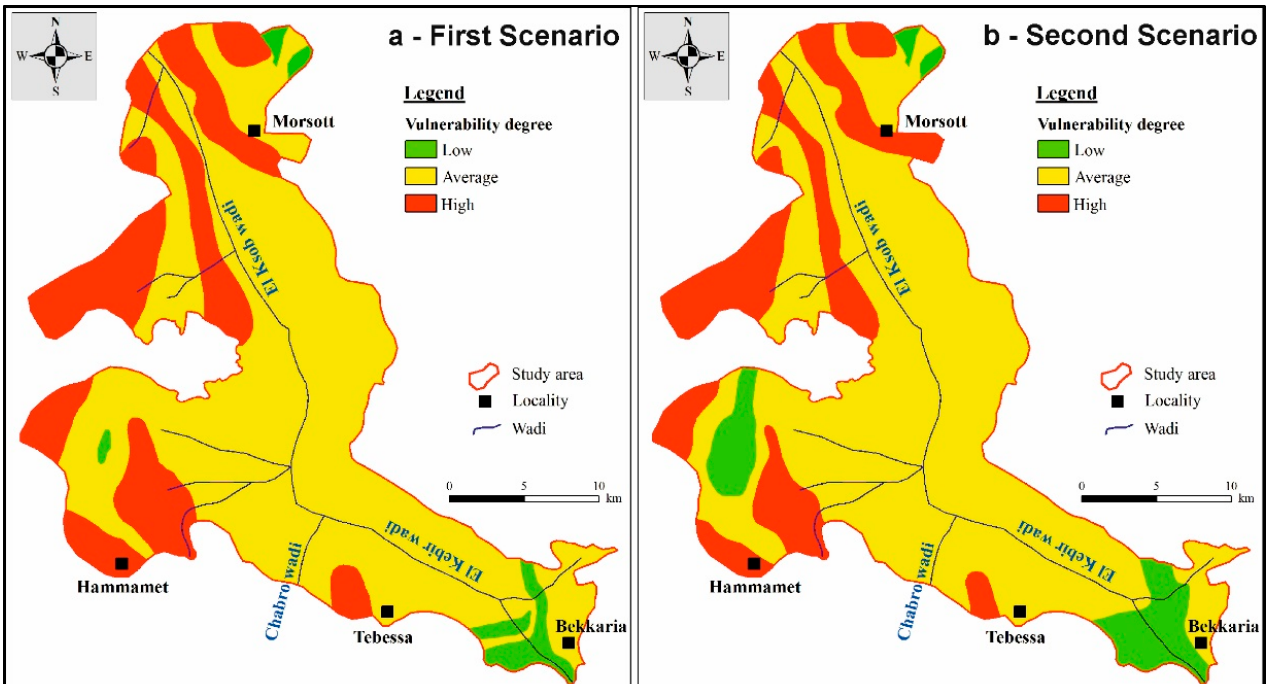
Figure 11. Future DRASTIC classification according to the two simulated scenarios.